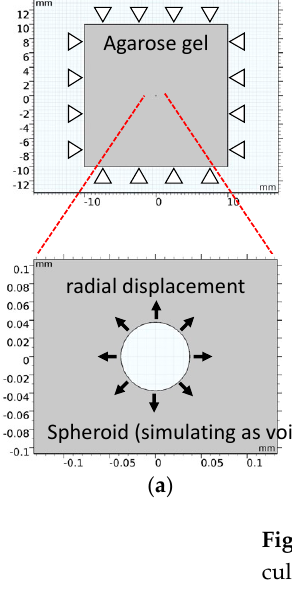
Figure 3. Quantitative analyses for spheroid growth using phase-contrast microscopy images.